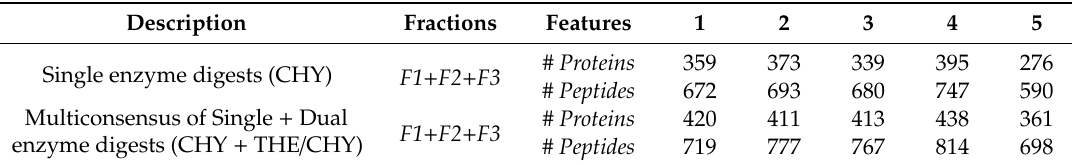
Figure 2. Venn diagrams highlighting the distribution of identified proteins (panels ( a ) and ( c )) and peptides (panels ( b ) and ( d )) among the three different protein fractions subjected to specific digestion with chymotrypsin. Table 2. Summary of the main features obtained by bottom-up proteomic characterization of the protein fraction collected for each genotype. # number of identified proteins or